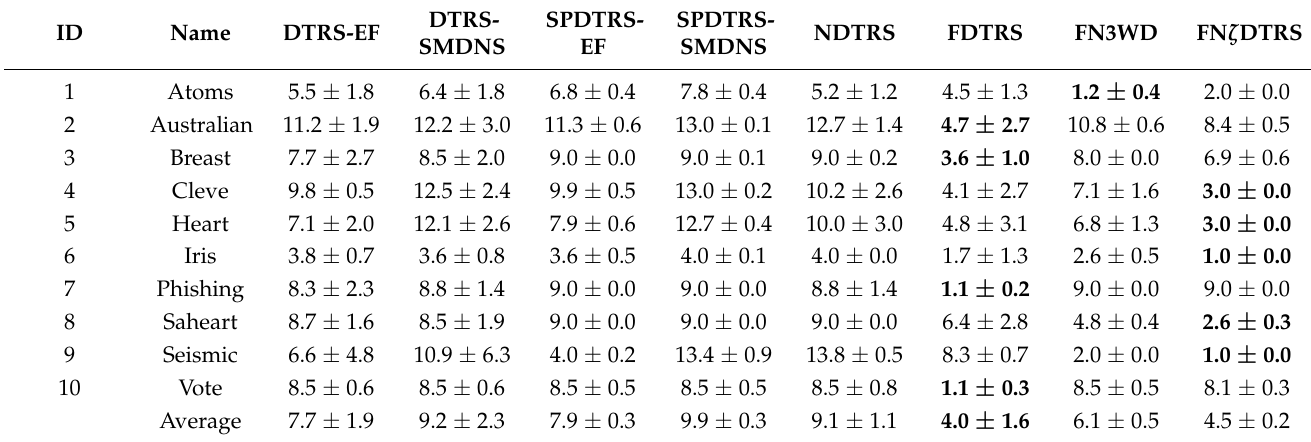
* Bolded indicates that the model achieves the best performance on this dataset. Table 6. The number of reduction